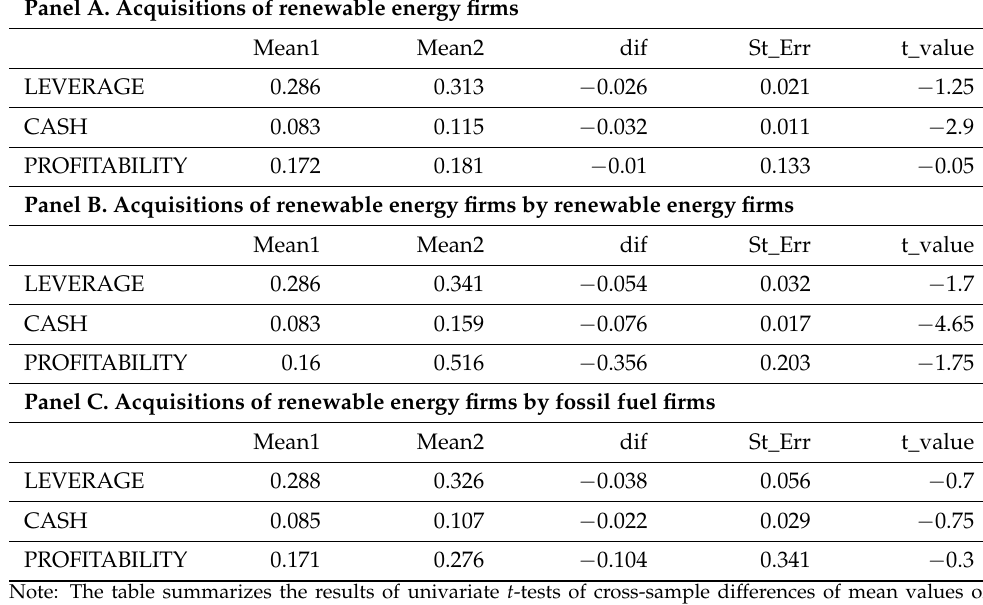
Table 4. Acquirer characteristics and deal details: cross-sectional comparison depending on the target type. Panel A. Acquisitions of renewable energy